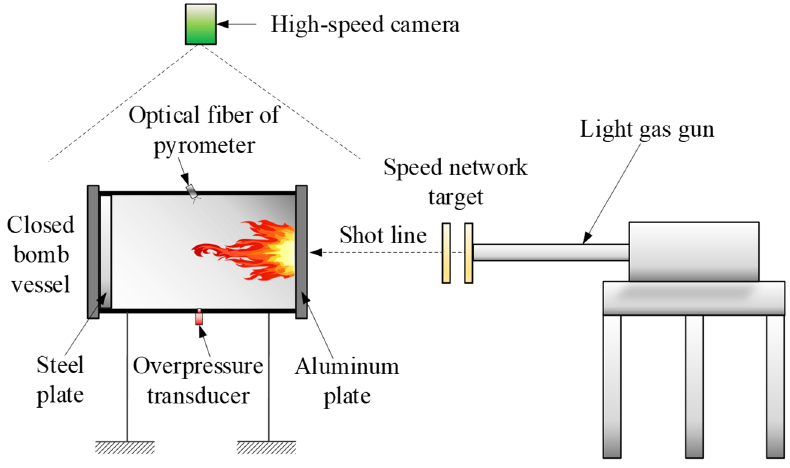
Figure 3. Test system of the energy release performance of RMs.